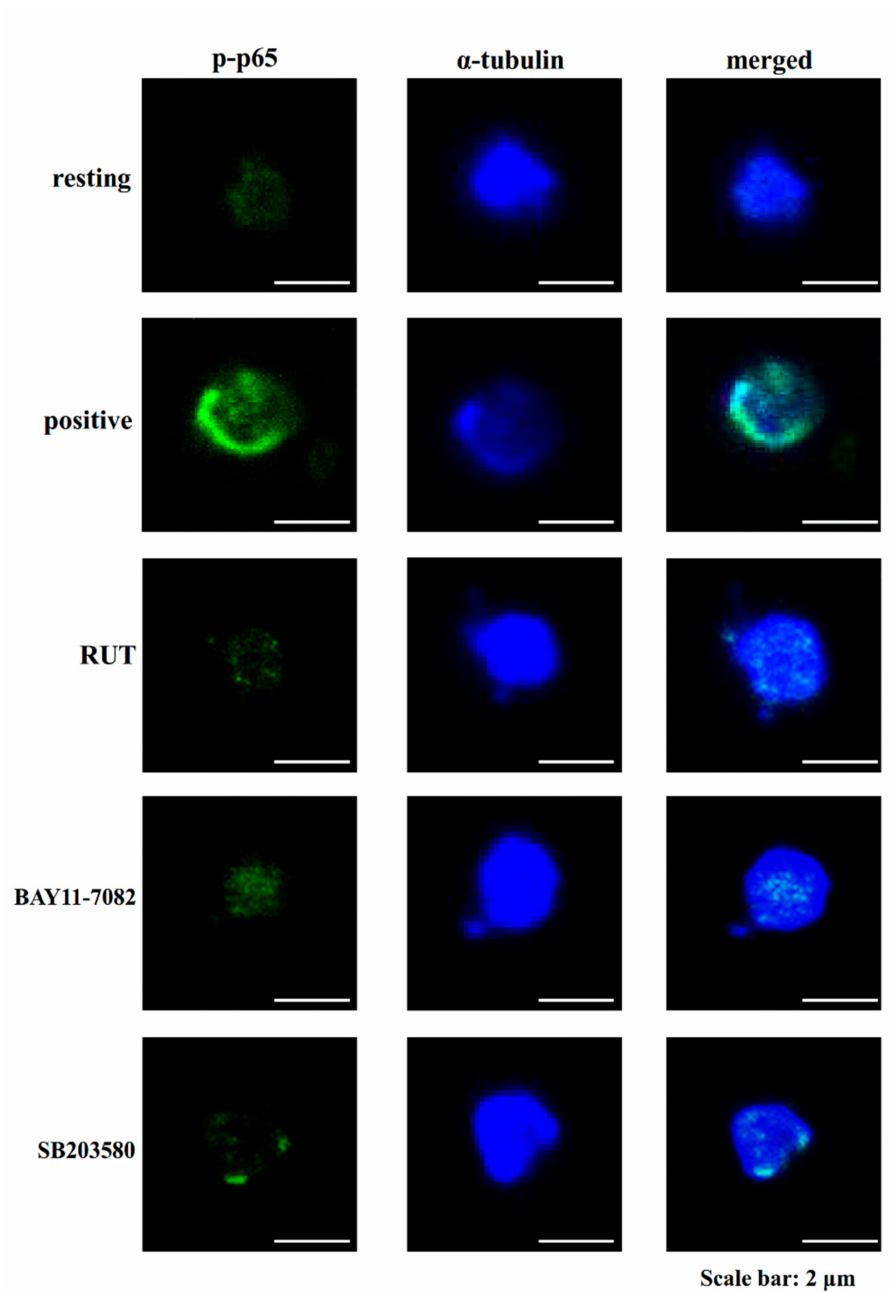
Figure 4. Confocal laser fluorescence of rutaecarpine, BAY11-7082, and SB203580 in the re- duction in p65 phosphorylation in human platelets stimulated by collagen. Washed platelets (1.2 × 10 9 cells/mL) were preincubated with rutaecarpine (RUT; 6 µ M), BAY11-7082 (6 µ M), or SB203580 (20 µ M), followed by the addition of collagen (1 µ g/mL) to trigger platelet aggregation. The confocal images of phosphorylated p65 (green fluorescence) and α -tubulin (blue fluorescence) were observed using goat anti-rabbit CF TM 488A Dye and goat anti-mouse CF TM 405M Dye, respectively. The profiles represent four similar studies. Bar: 2 µ